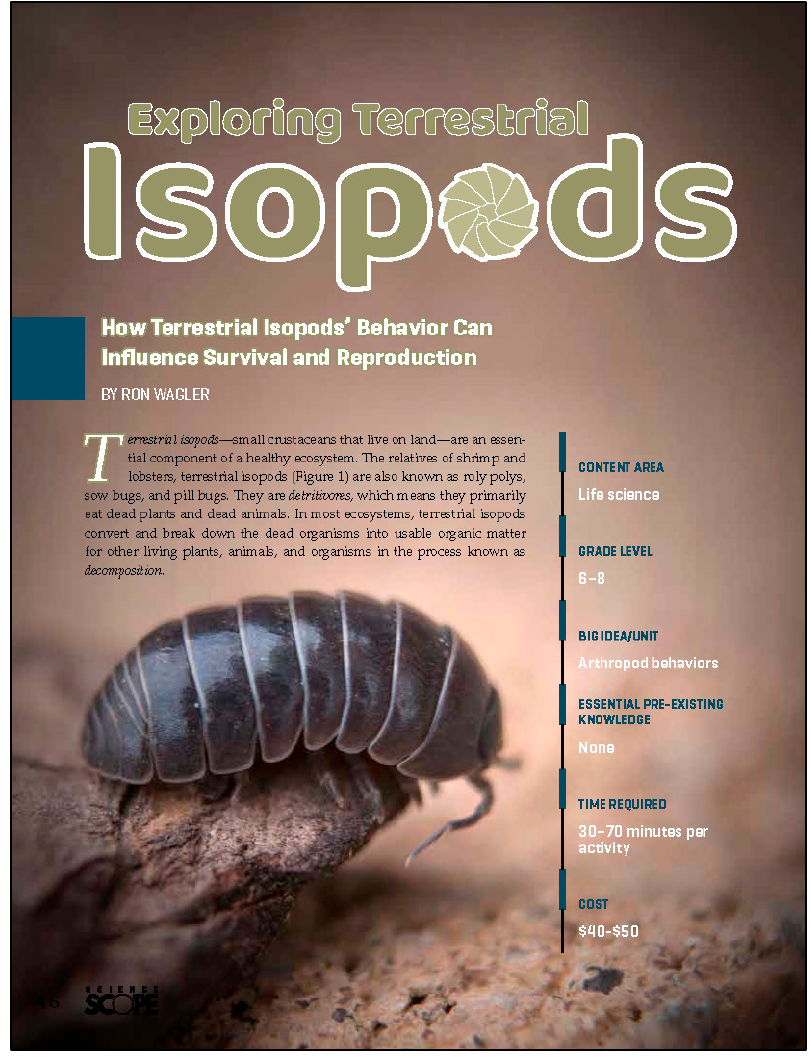
Figure 2. Exploring Terrestrial Isopods: Example Hands-on Inquiry Based Terrestrial Isopod Activities used in the Study.